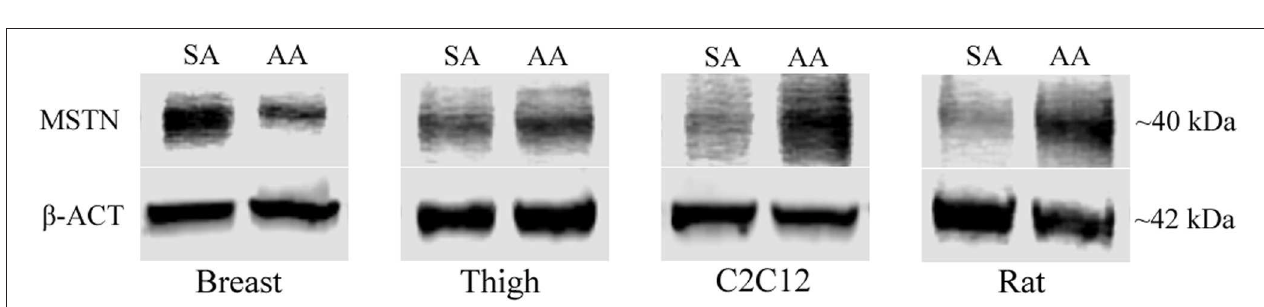
FIGURE 2 | MSTN Western blot of treated myotubes. Western blot images of MSTN protein isolated from myotubes from C2C12 cells, primary breast, primary thigh, or primary rat cultures after treatment with ammonium acetate (10mM) or sodium acetate (10mM) for 24h.